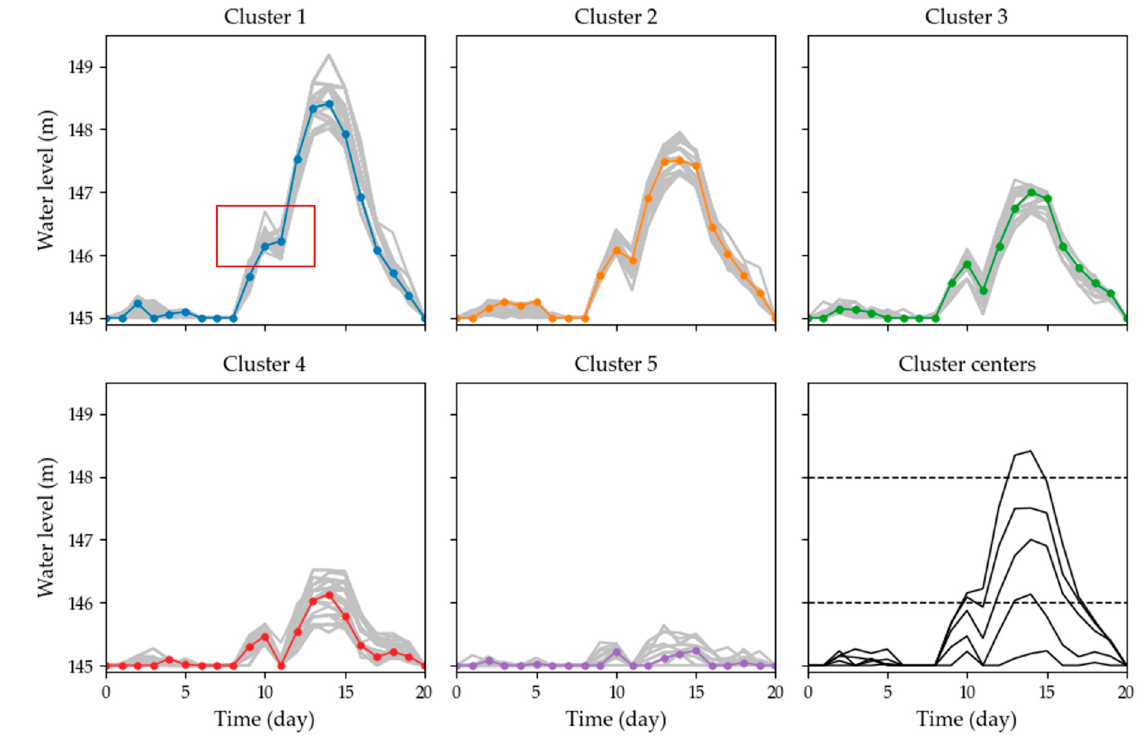
Figure 8. Clustering results on reservoir operation processes via dynamic time warping (DTW). Clusters are drawn in each subfigure separately. The cluster centers are shown in the last subfigure.